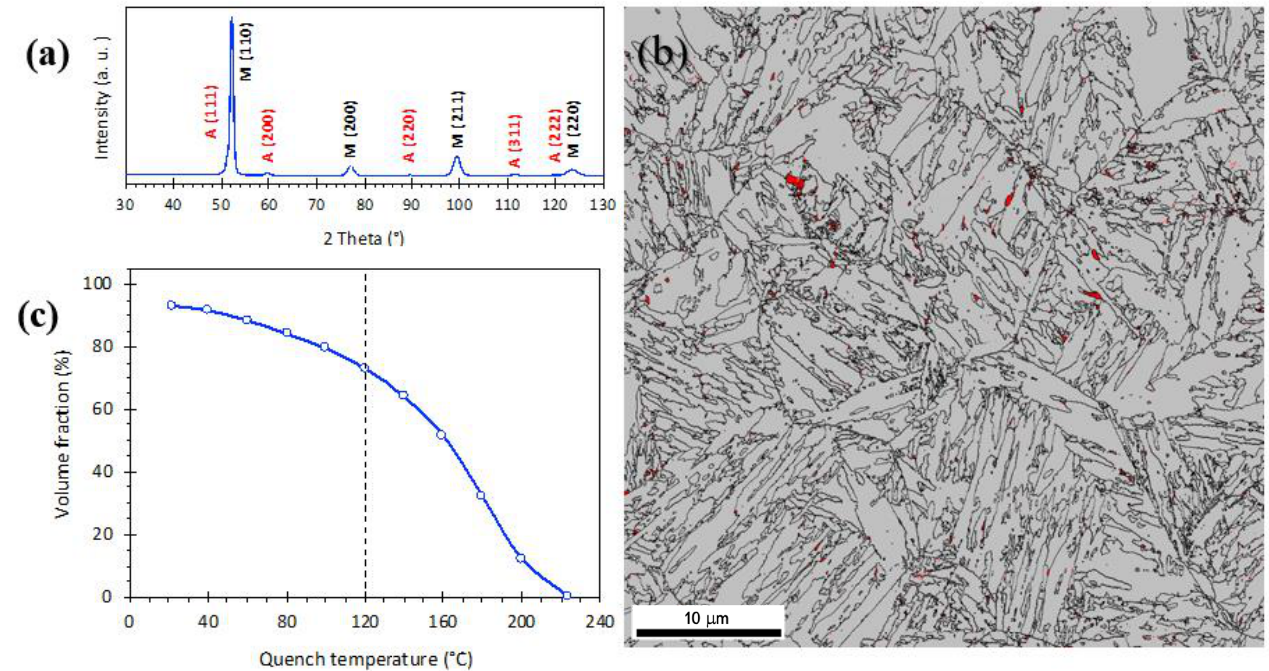
Figure 2. ( a ) XRD pattern of the sample quenched to RT after annealing at 900 °C, indicating mar- tensite (M) and weak austenite (A) peaks, ( b ) corresponding EBSD phase map (austenite in red and martensite in grey), and ( c ) volume fraction of martensite at different quench temperatures.